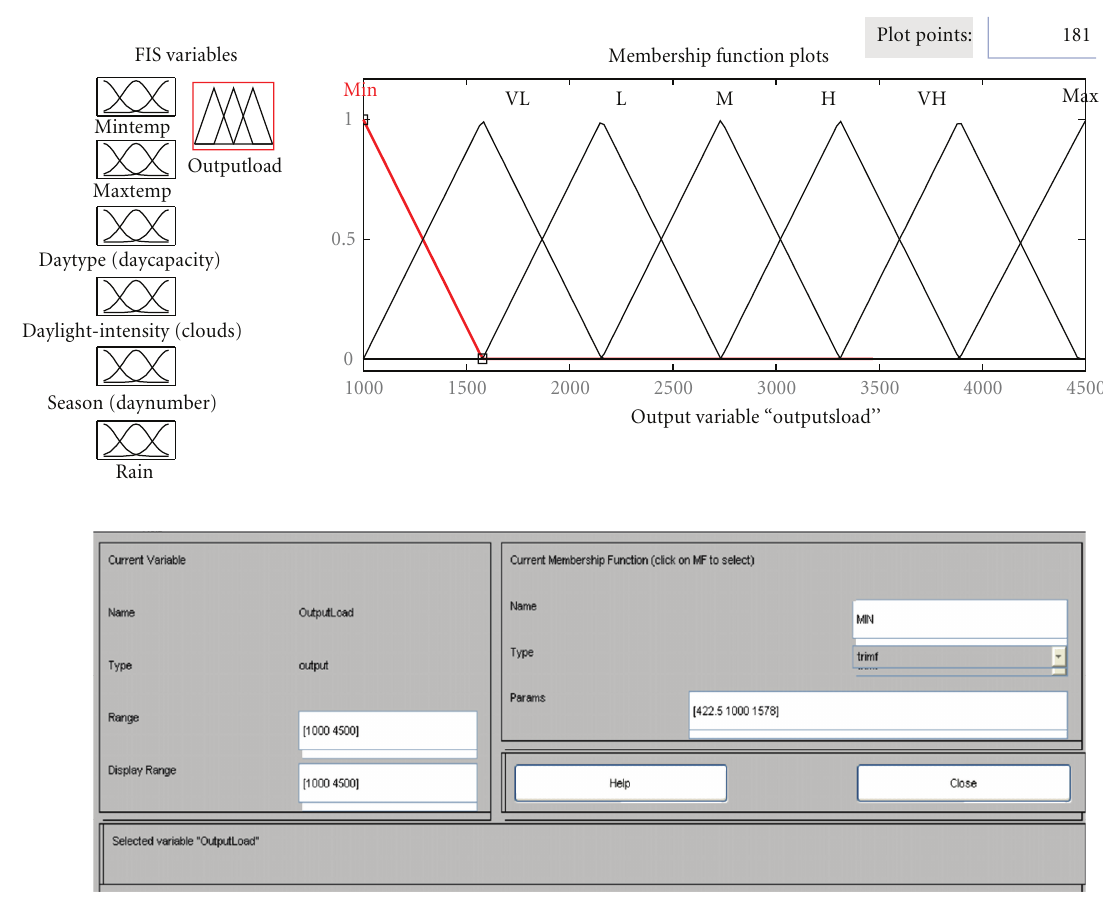
Figure 2: Membership functions of fuzzy inference